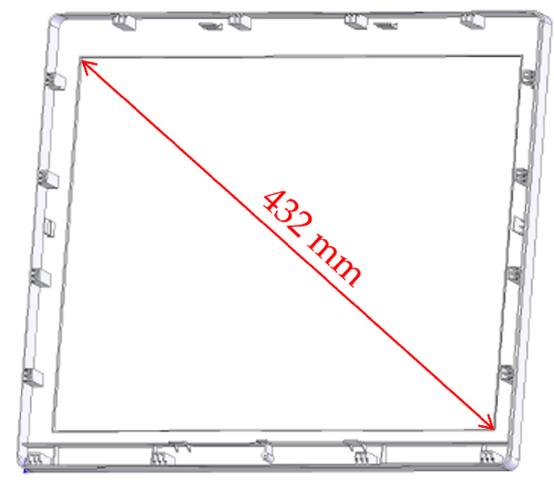
Figure 1. Three-dimensional drawing of an LCD frame .